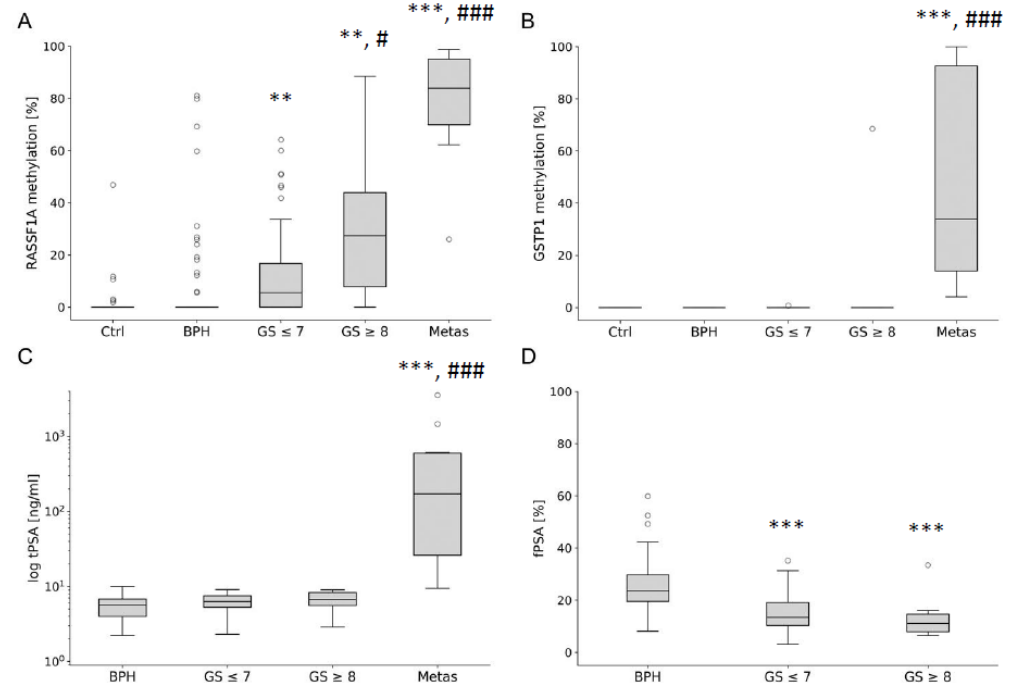
Figure 5. Methylation analyses of RASSF1A and GSTP1 DNA fragments compared to tPSA and fPSA in healthy, BPH and different PCa subgroups. Box plots consist of the median as ‘center value’, the 25th and 75th percentiles as box edges, and the 10th and 90th percentiles as whisker boundaries. PCa and BPH cohorts were selected to include patients with tPSA values between 2.0 and 10 ng/mL, where further diagnostic validation is most crucial. Percentages of RASSF1A ( A ) and GSTP1 ( B ) DNA methylation as well as tPSA ( C ) and fPSA ( D ) were analysed in BPH ( n = 58), PCa patients with Gleason scores (GS) ≤ 7 ( n = 55), GS ≥ 8 ( n = 10), and metastatic prostate carcinoma (Metas, n = 10). ( A , B ) The healthy control group (Ctrl) was selected to be significantly younger than both the BPH patients and the PCa cohort to minimise the likelihood of undetected malignant disease. ( C , D ) Dashed lines represent cutoffs for tPSA (4 ng/mL) and fPSA (20%), which are used in routine diagnostics (Abbott). ( D ) No fPSA measurements were performed for metastatic PCa patient samples. The symbols * and # indicate significant differences compared to Ctrl and BPH (*) or low GS PCa group (#) with p < 0.05 (#), p < 0.01 (**), and p < 0.001 (***, ###).